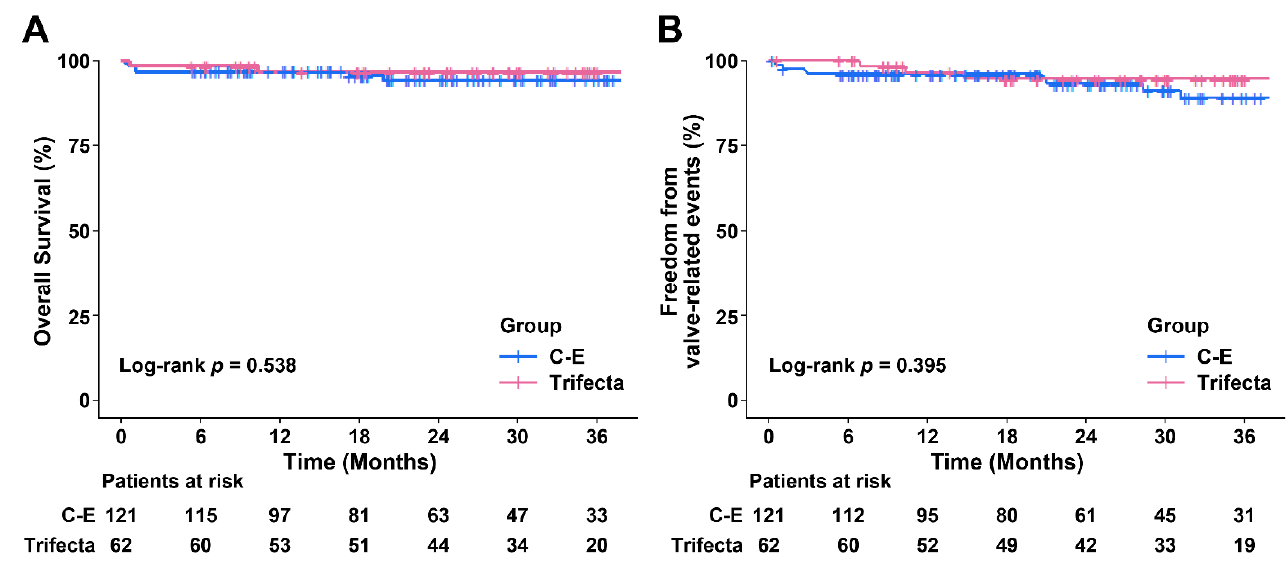
Figure 1. Survival and freedom from valve-related events in the unmatched cohort: ( A ) The Kaplan–Meier estimate of survival for the Carpentier-Edwards (C-E, blue line) and Trifecta (red line) valves; ( B ) The same Kaplan–Meier estimate of freedom from valve-related events.